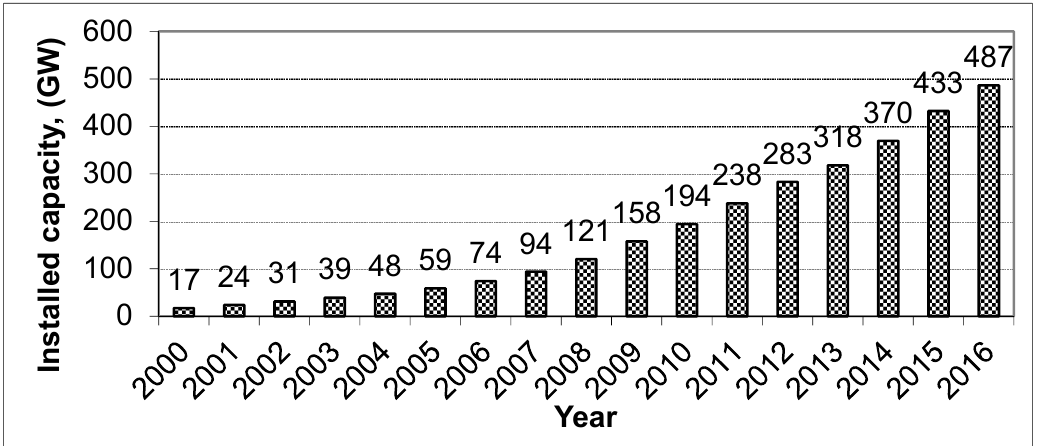
Figure 1. Cumulative global wind power installed capacity [2].